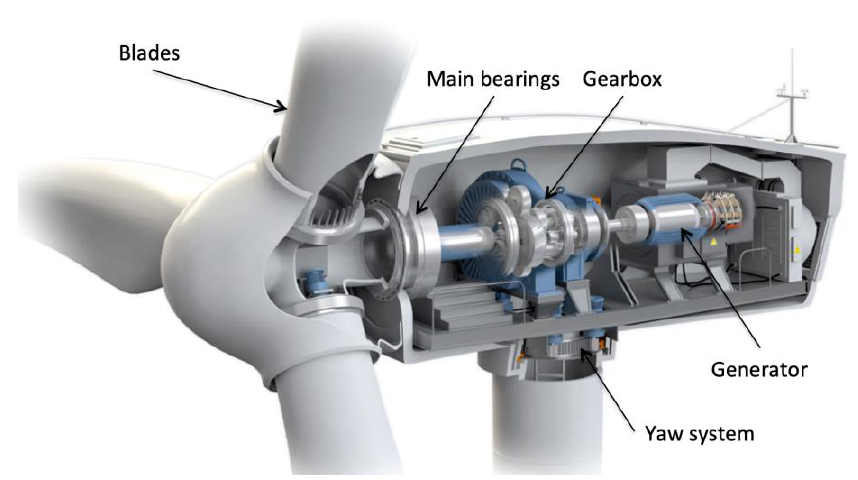
Figure 1. Important components of a horizontal wind turbine.